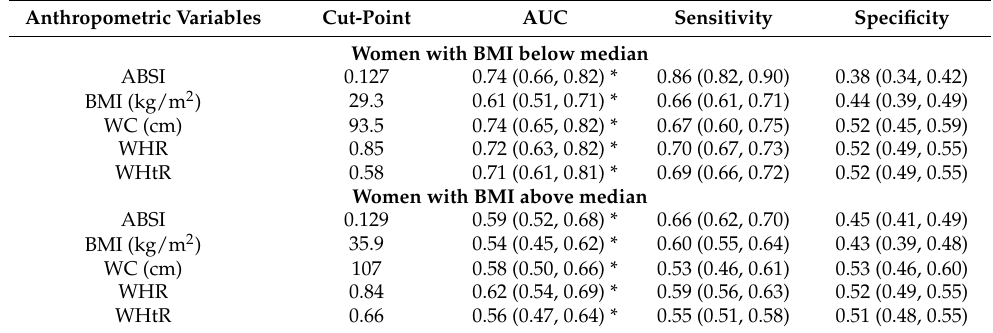
Table 2. Optimal cut-points for detecting MetS (without WC) using simple anthropometric indices in subjects with BMI below or above median